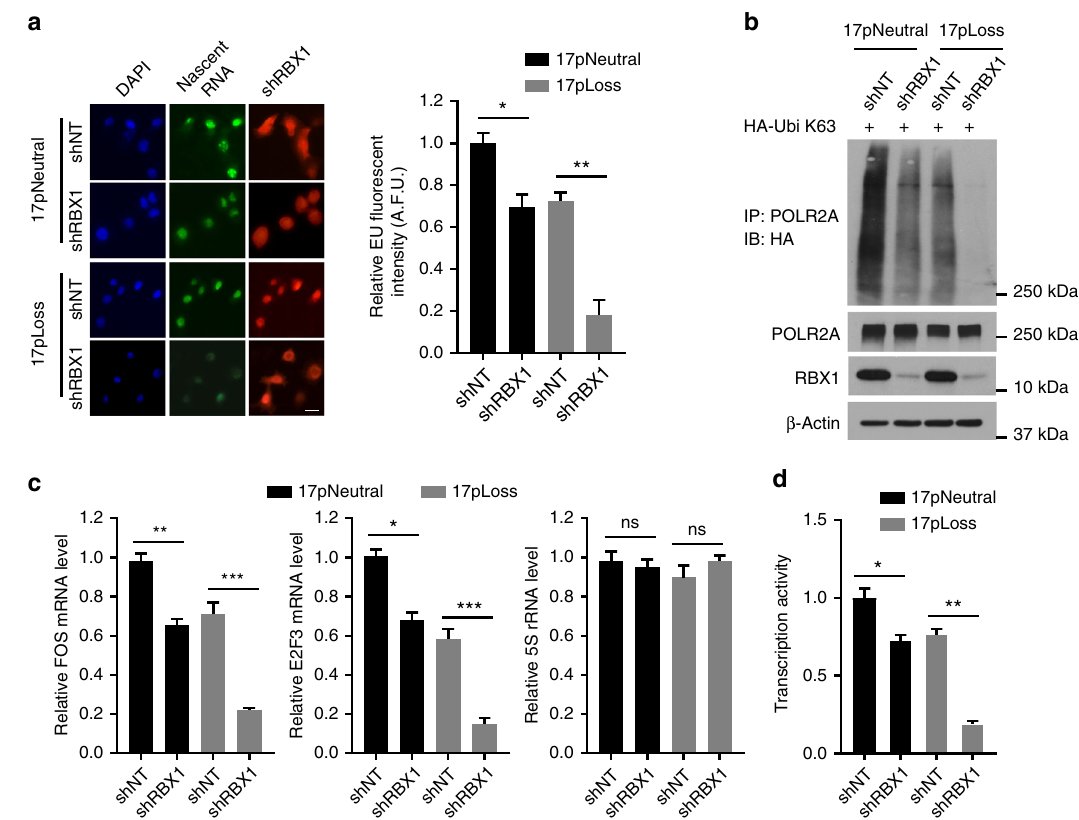
Fig. 6 RBX1 promotes the POLR2A-dependent RNA transcription. a Global RNA synthesis in the parental and isogenic 17p loss DU145 cells was evaluated by measurement of 5-EU incorporation after Dox-inducible RBX1 knockdown and the intensity was quanti fi ed with the CellPro fi ler Software. Scale bar, 25 µ m. b Effect of RBX1 knockdown on the levels of lysine-63 (K63) ubiquitination of POLR2A in the parental and isogenic 17p loss DU145 cells. c qPCR analysis of the levels of short-lived mRNA (FOS and E2F3) compared to the control 5S rRNA in the isogenic DU145 cells with or without Dox-inducible RBX1 knockdown. d qPCR analysis of the in vitro transcription activity using HelaScribe DNA template. Data are representative of three independent experiments and analyze by unpaired two-tailed t -test. Error bars denote SD. ns not signi fi cant; **, p < 0.01; ***, p <